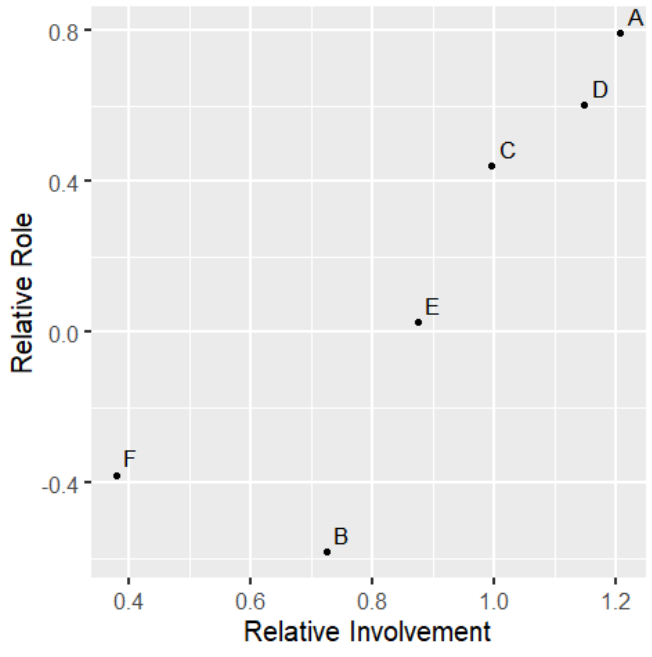
Figure A2. Relative Role vs. Relative Involvement of concepts in illustrative